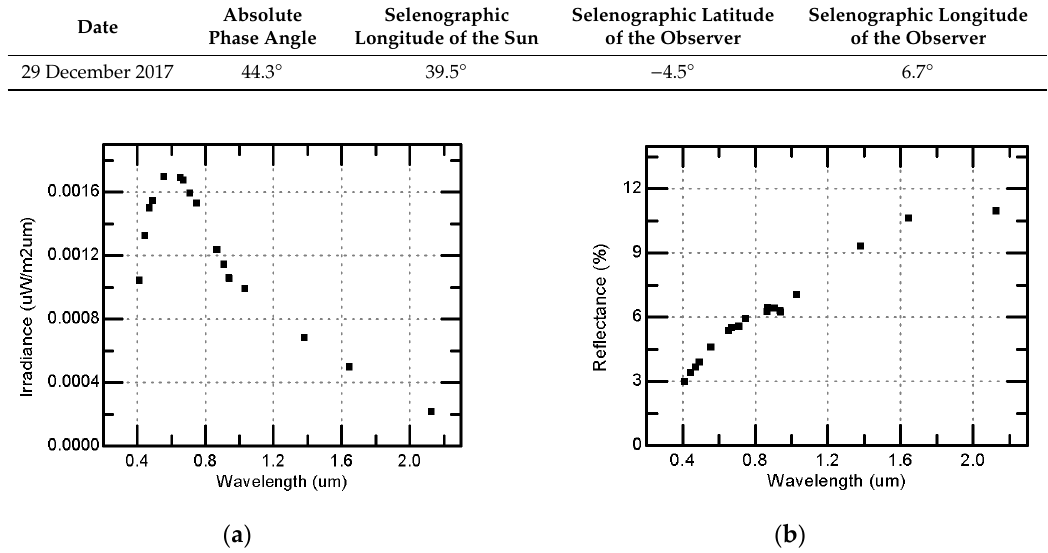
Table 2. Date of the observations and geometry.